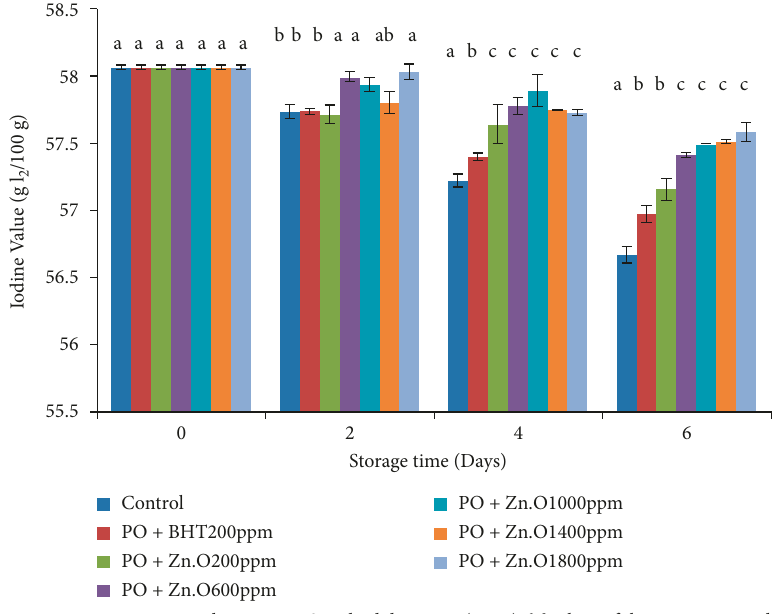
Figure 5: Changes in iodine value of palm olein enriched with different concentrations of ginger extract during storage at frying temperature. BHT: butylated hydroxytoluene; PO: palm olein; Zn.O: Zingiber officinale (ginger); control: palm olein without antioxidant; PO+BHT 200 ppm : palm olein+ 200ppm BHT; PO +Zn.O 200ppm : palm olein+200ppm ginger root extract; PO +Zn.O 600ppm : palm olein+600ppm ginger root extract; PO+Zn.O 1000ppm : palm olein+1000ppm ginger root extract; PO+Zn.O 1400ppm : palm olein+1400ppm ginger root extract; PO +Zn.O 1800ppm : palm olein+1800ppm ginger root extract. Data are presented as mean ± standard